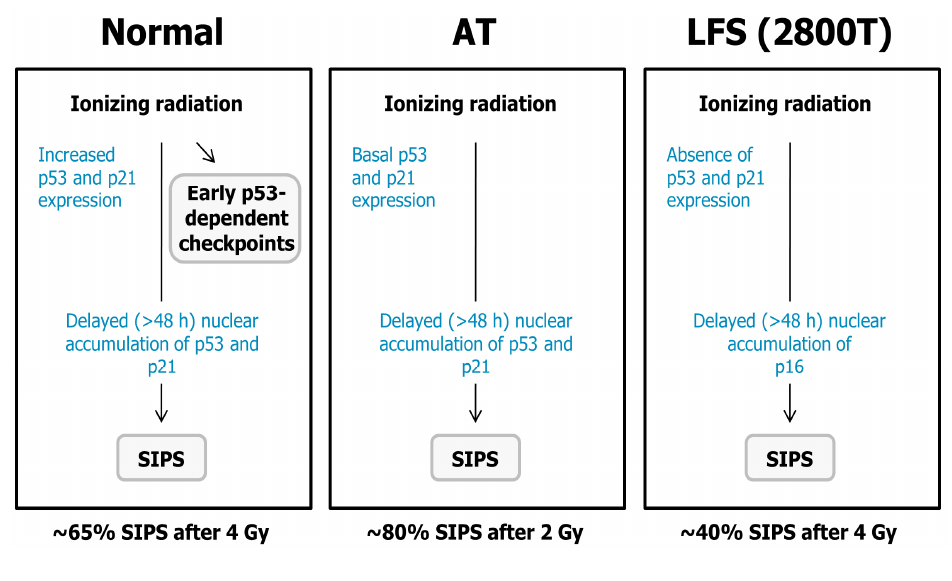
Figure 5. Schematic representation of the uncoupling of p53-dependent early (cell cycle checkpoints) and late (SIPS) responses induced by ionizing radiation in some genetic backgrounds. The observations for LFS were made using strain 2800T which does not exhibit wild-type p53 function at early passages